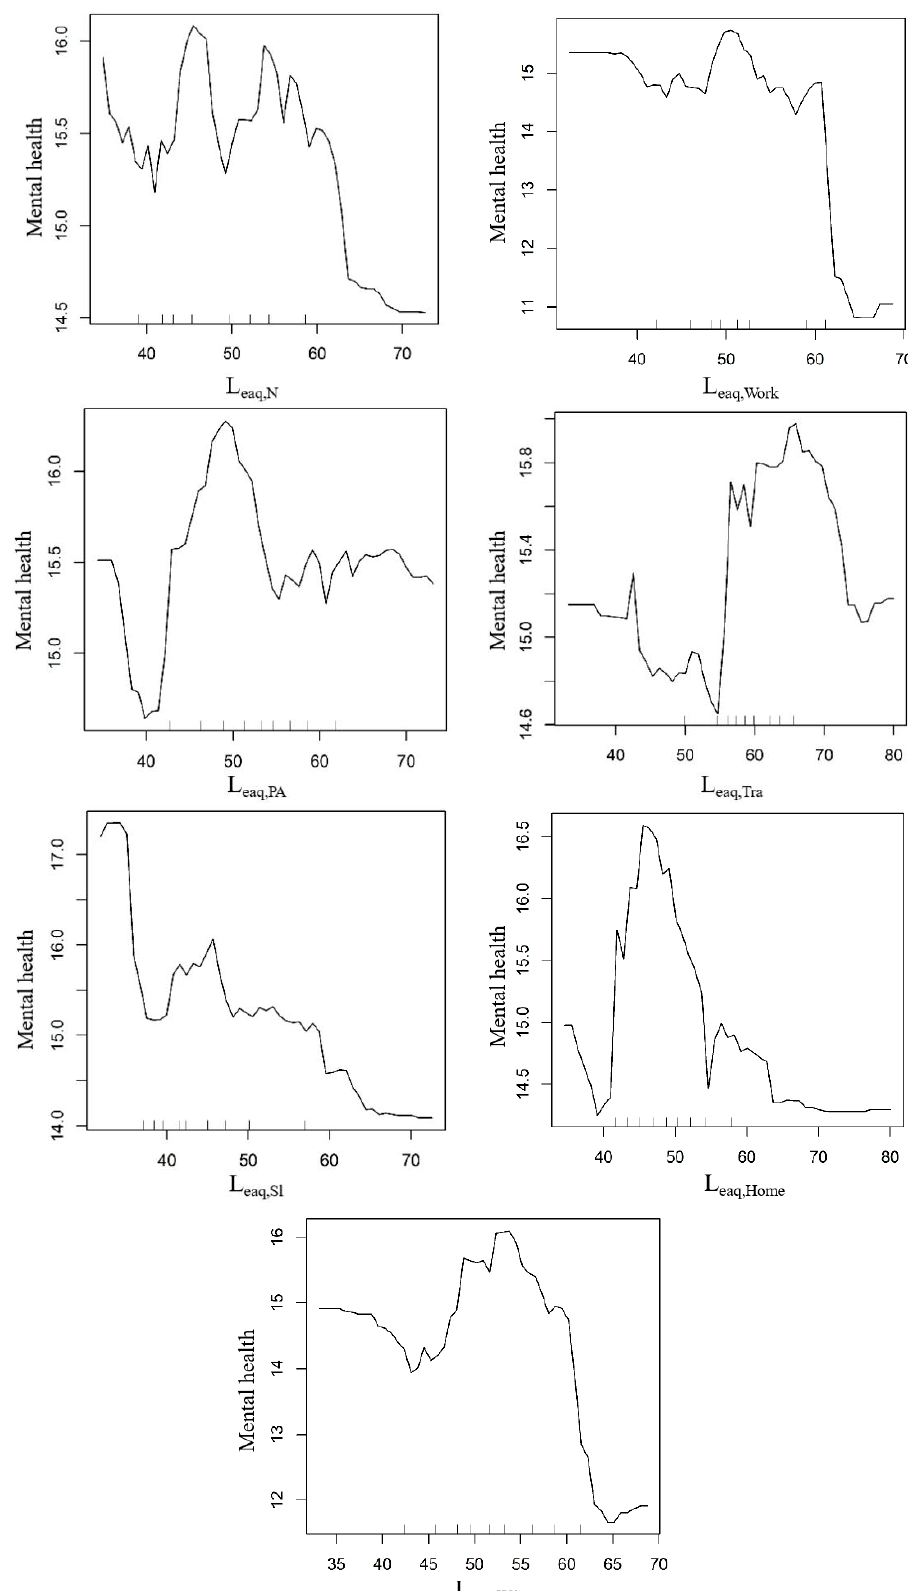
Figure 10. The nonlinear relationship between noise exposure and mental health. The difference in self-reported mental health among residents exposed to different levels of noise at night was 1.5 points. When the noise value at night was between 35 and 60 dB, its impact on the mental health level of residents is not clear. In this range, the mental health level fluctuated irregularly with the change of the noise value of about 0.5 points. When the noise value reached about 60 dB, the mental health level decreased sig- nificantly, and then decreased slowly until it remained at the lowest level. The threshold for mental health effects of noise exposure at work was 60 dB. When the noise value was lower than 60 dB, its impact on mental health was very small, and the corresponding mental health value was about 14.5 to 15.5 points. When the noise level reached 60 dB, the mental health level dropped sharply, from 15 points to 11 points. Ac- cording to the WHO (Five) Well-Being Index (1998 version), a score below 13 indicates poor health. We concluded that the tolerance threshold of noise at work was 60 dB; ex- ceeding this level will lead to mental health problems in residents. For the three models of noise exposure during personal business, noise exposure dur- ing travel, and noise exposure at home, it does not seem that the lower the noise level, the better the mental health. Considering the changes in mental health levels, the optimal sound range was found for personal affairs, travel and staying at home. Among them, when the noise value of personal affairs was around 40 dB, the mental health level was the lowest. However, when the noise value was in the range of 42–50 dB, the mental health level increased with the increase in the noise value. However, when the noise value ex- ceeded 52 dB, the mental health level dropped sharply. When the noise value reached 55 dB, the mental health level dropped to about 15.5 and then stayed basically unchanged. It can be seen that around 50 dB (45–52 dB) seems to be the most comfortable sound level for personal affairs. Similarly, when the noise value was 43–53 dB, the mental health level was at the lowest level. When the noise value was lower than 43 dB or higher than 70 dB, the mental health level was at the middle level. Thus, the noise value of 55–70 dB was the best range of mental health level during travel. The lowest level of mental health was found at home with noise levels lower than 42 dB or higher than 52 dB, whereas the opti- mal range for mental health was 44–52 dB. The mental health of residents was most sensitive to noise during sleep, and the dif- ference in the mental health value was 3.4 points. When the noise level increased from 34 dB to 37 dB, the mental health score dropped sharply by about 2.2 points. Subsequently, the mental health score gradually decreased with the increase in the noise value, until the noise value reached 64 dB, the mental health score also fell to the lowest level and basically did not change. Similar to the model of noise exposure at work, the mental health score dropped sig- nificantly from 15 (good health) to 12 (poor health) when noise exposure levels exceeded 60 dB at the workplace. The difference was that when the noise level was between 32 dB